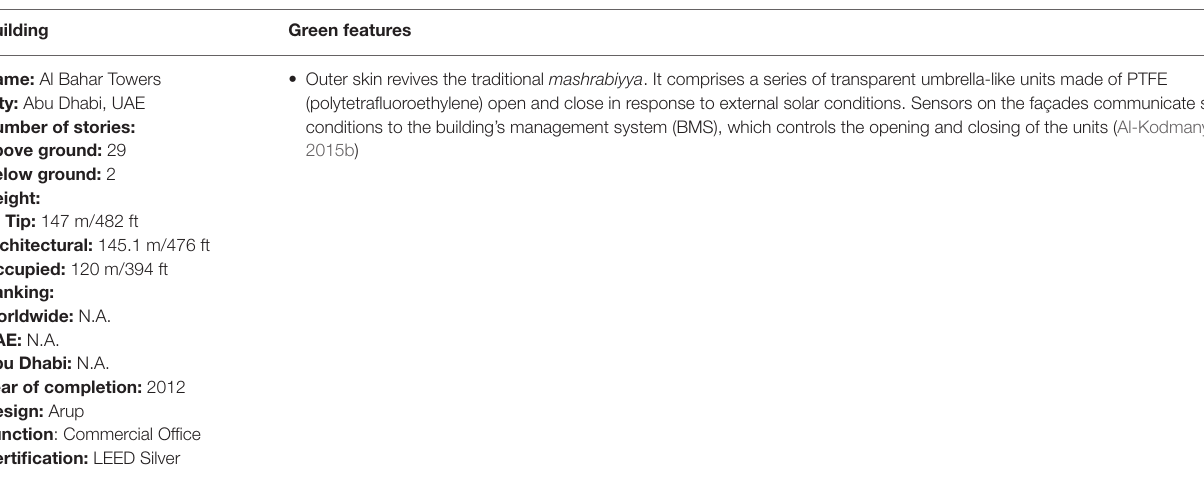
TABLE 12 | Al Bahar Towers: Key green features.